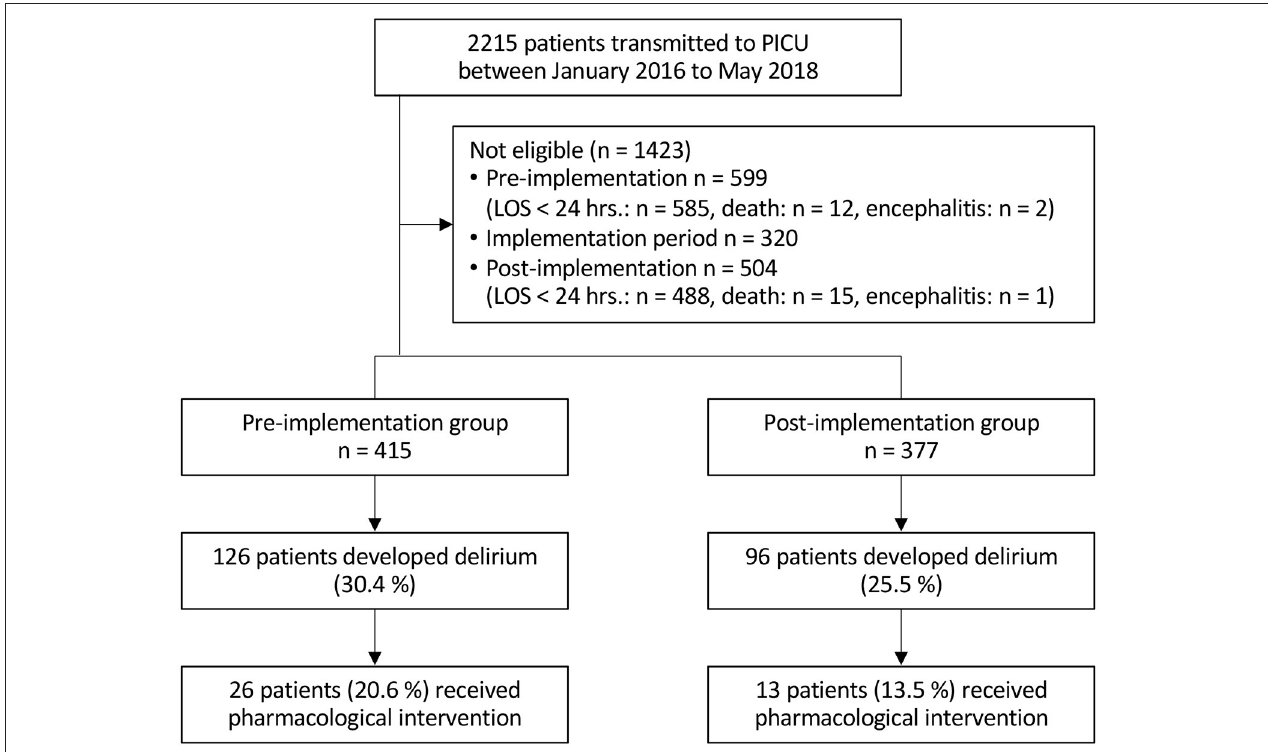
FIGURE 3 | CONSORT flow diagram (LOS, Length of